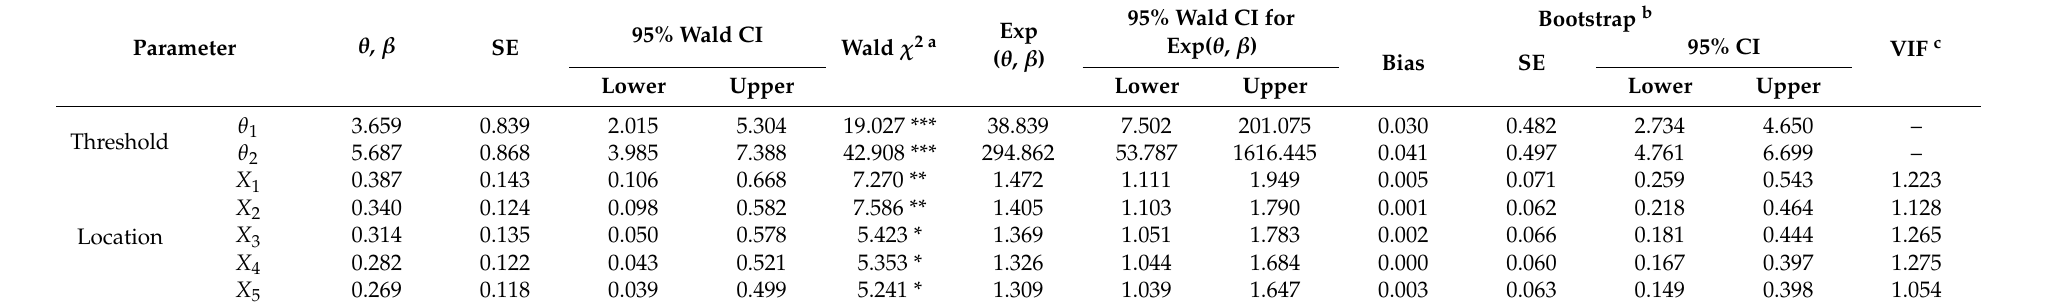
Table 4. Bootstrapped ordinal logistic regression model ( N =